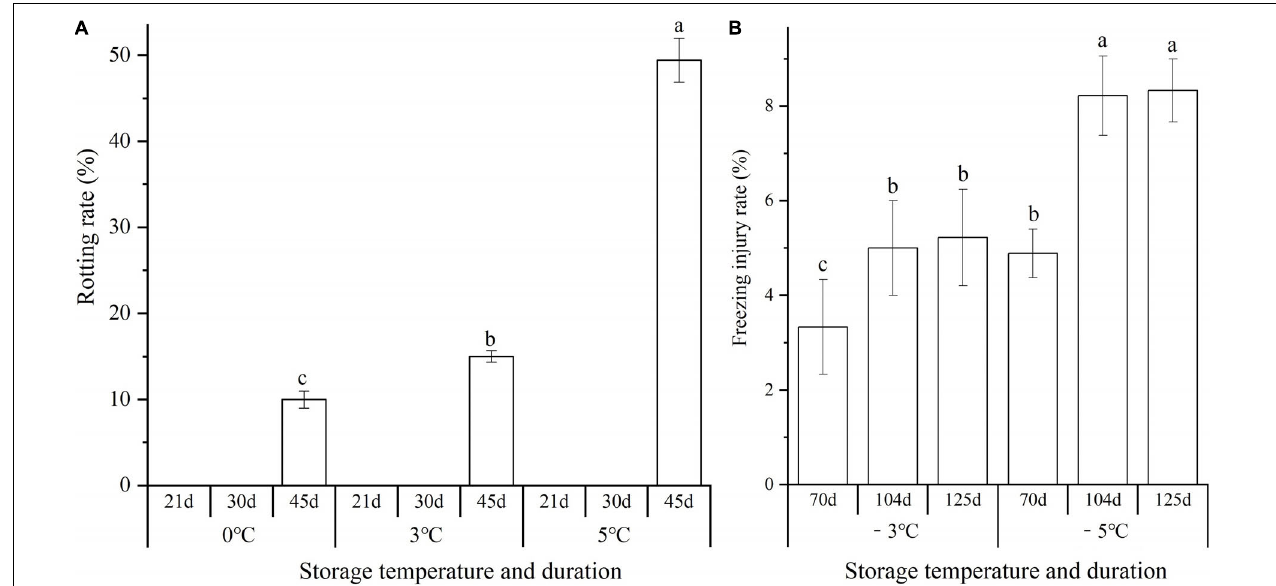
FIGURE 1 | Changes in the rotting rate (RR) and freezing injury rate (FIR) of seedlings at different storage temperatures and durations. Panels (A,B) represent the RR and FIR, respectively. Different lowercase letters represent a significant difference ( P < 0.05) in the average value of different seedlings (large, medium, and small sizes) among different temperatures and